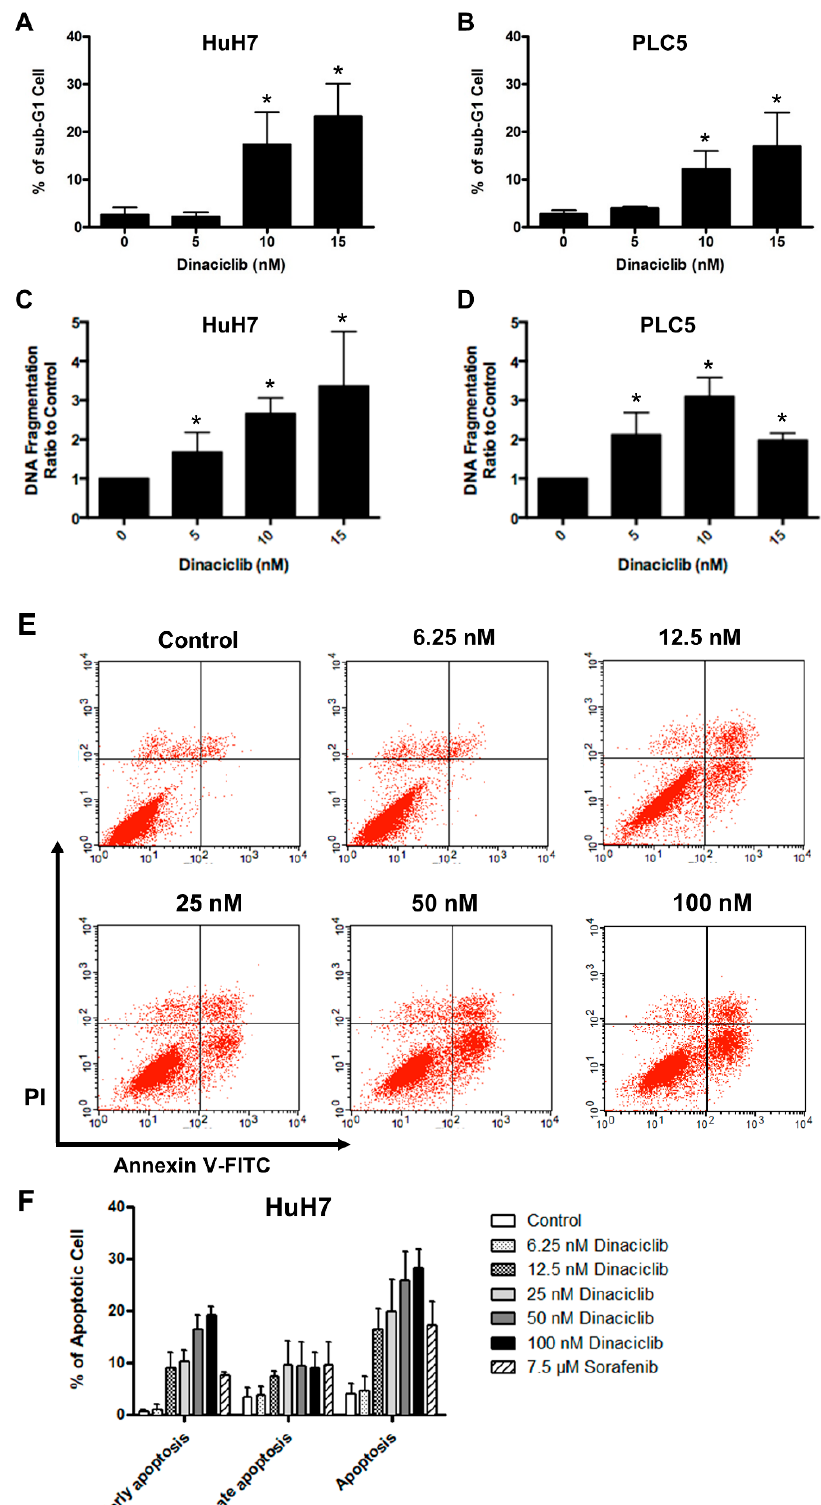
Figure 2. ( A , B ) Cell cycle assay indicating the sub-G1 fractions of ( A ) HuH7 and ( B ) PLC5 cells after treatment with dinaciclib for 48 h. ( C , D ) Cell death detection ELISA indicating the amount of DNA fragmentation of ( C ) HuH7 and ( D ) PLC5 cells after treatment with dinaciclib for 72 h. ( E , F ) Flow cytometry results with HuH7 cells stained with annexin-V and PI after treatment with dinaciclib or sorafenib for 72 h. * denotes statistical significance compared to treatment with 0 nM